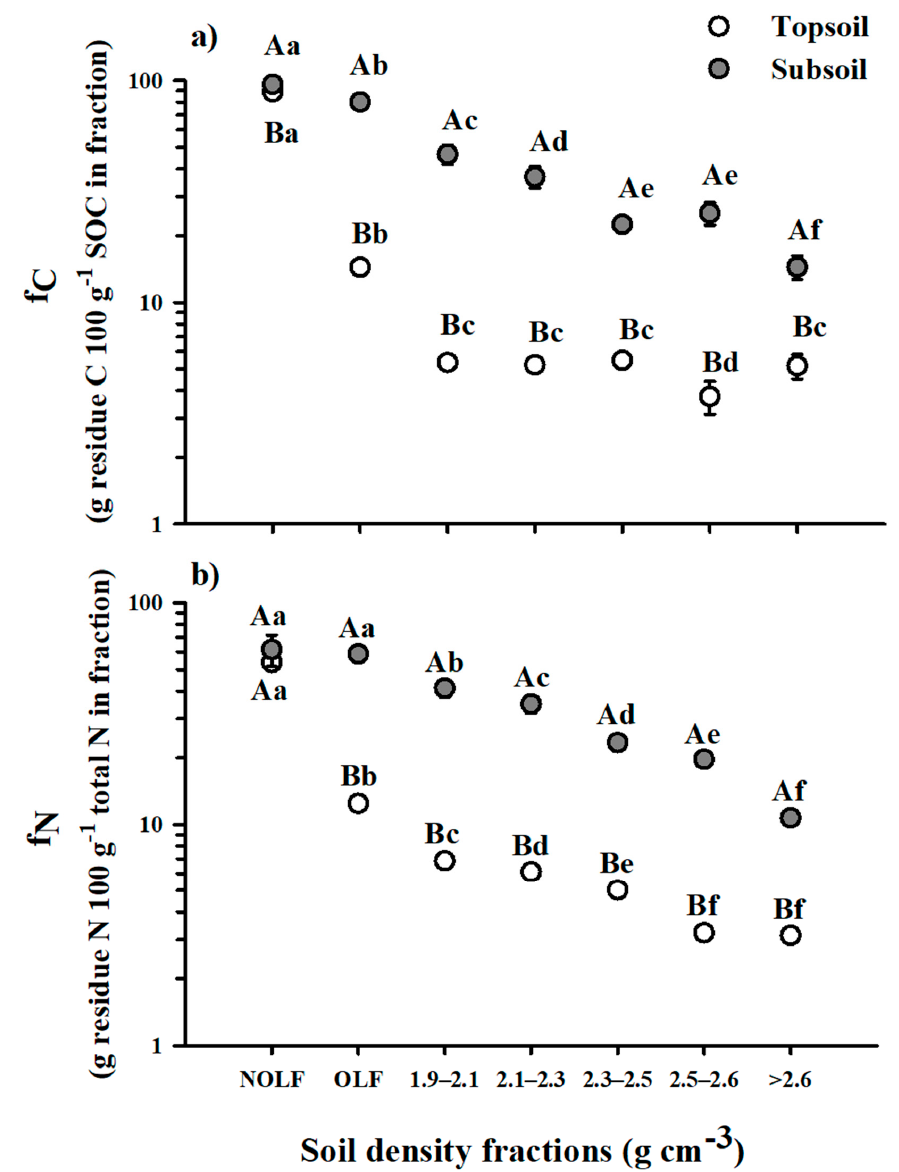
Figure 3. Fraction of ( a ) soil organic C (SOC) coming from residue C (f C , Equation (4)) and ( b ) total soil N coming from residue N (f N , Equation (4)) within density fractions in topsoil (0–20 cm) and subsoil (30–70 cm) after 51 d of incubation with 10 g C kg − 1 of 13 C- 15 N-labelled corn residues. Different uppercase letters indicate a significant difference between topsoil and subsoil within density fractions, and different lowercase letters indicate a significant difference between density fractions within soil according to Fisher’s least significant difference (LSD) test.